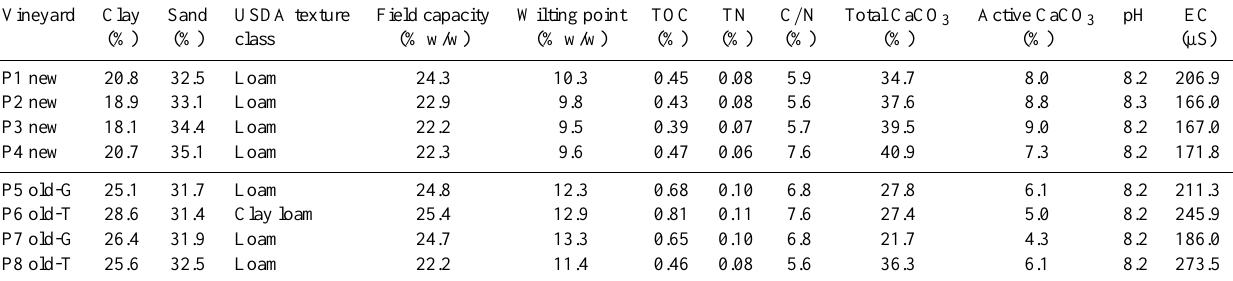
Table 2. Soil properties of the selected monitoring plots within each vineyard in the first year of study (soil depth: 0–15cm). Vineyard Clay Sand USDA texture Field capacity Wilting point TOC TN C / N